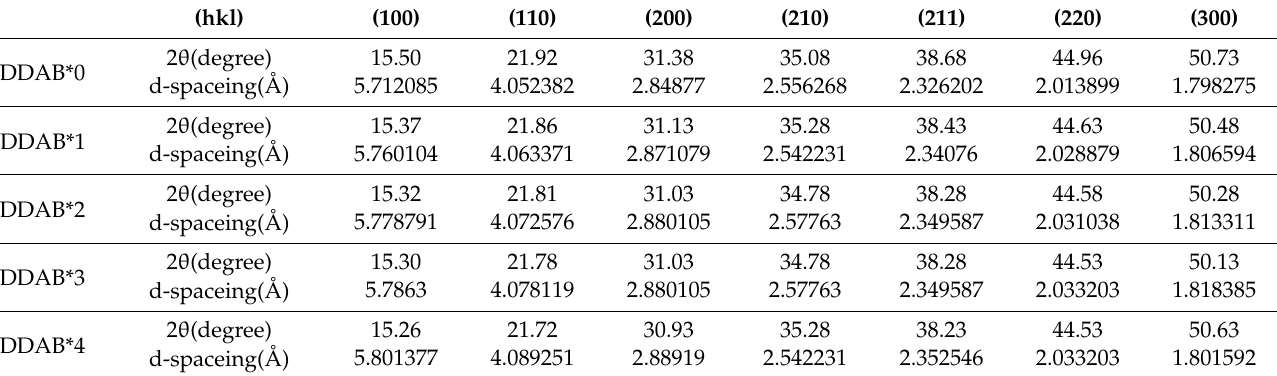
Figure 4. XRD pattern of CsPbCl x Br 3−x PQDs treated by different DDAB concentrations. Table 1. XRD peak positions of CsPbCl x Br 3 − x PQDs treated by different DDAB